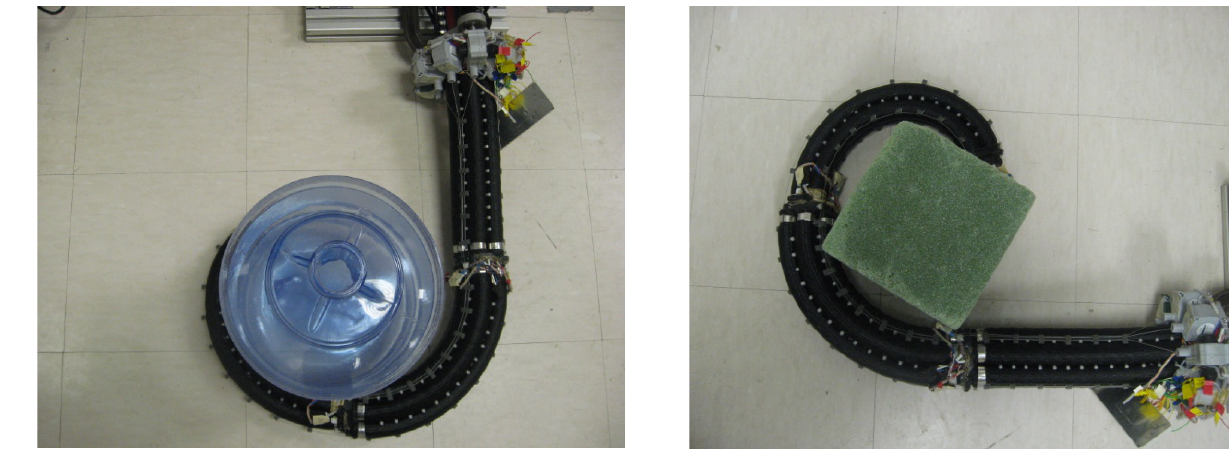
Figure 6b. The same object grasped using the tip section of the Octarm.